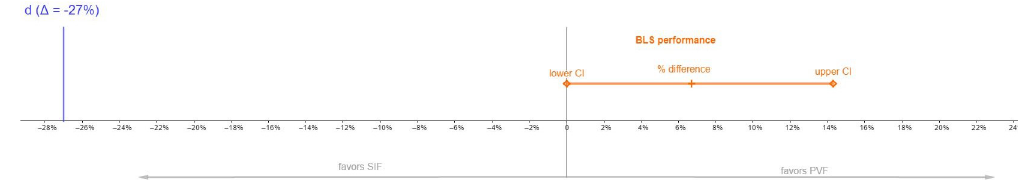
Fig 4. Non-inferiority results for overall BLS performance as measured with the BLS algorithm checklist. Notes . Proportion (%) difference, lower and upper 95% CI for BLS performance. The line marked “d” indicates the non-inferiority margin. Values < 0 favor SIF and values > 0 favor PVF. Significant non-inferiority is given when the lower CI lies above d. BLS: Basic life support.